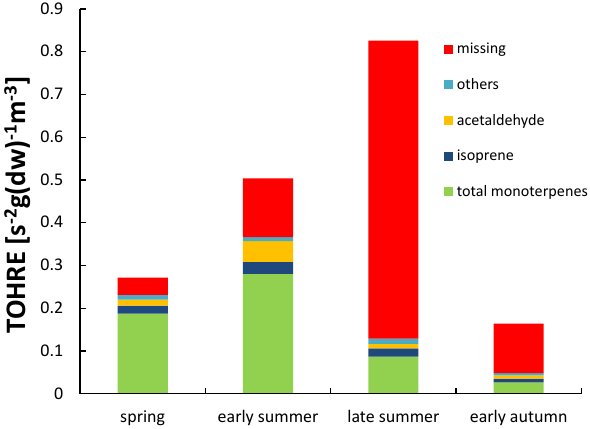
Fig. 7. Averaged measured TOHRE for the 4 defined periods: spring